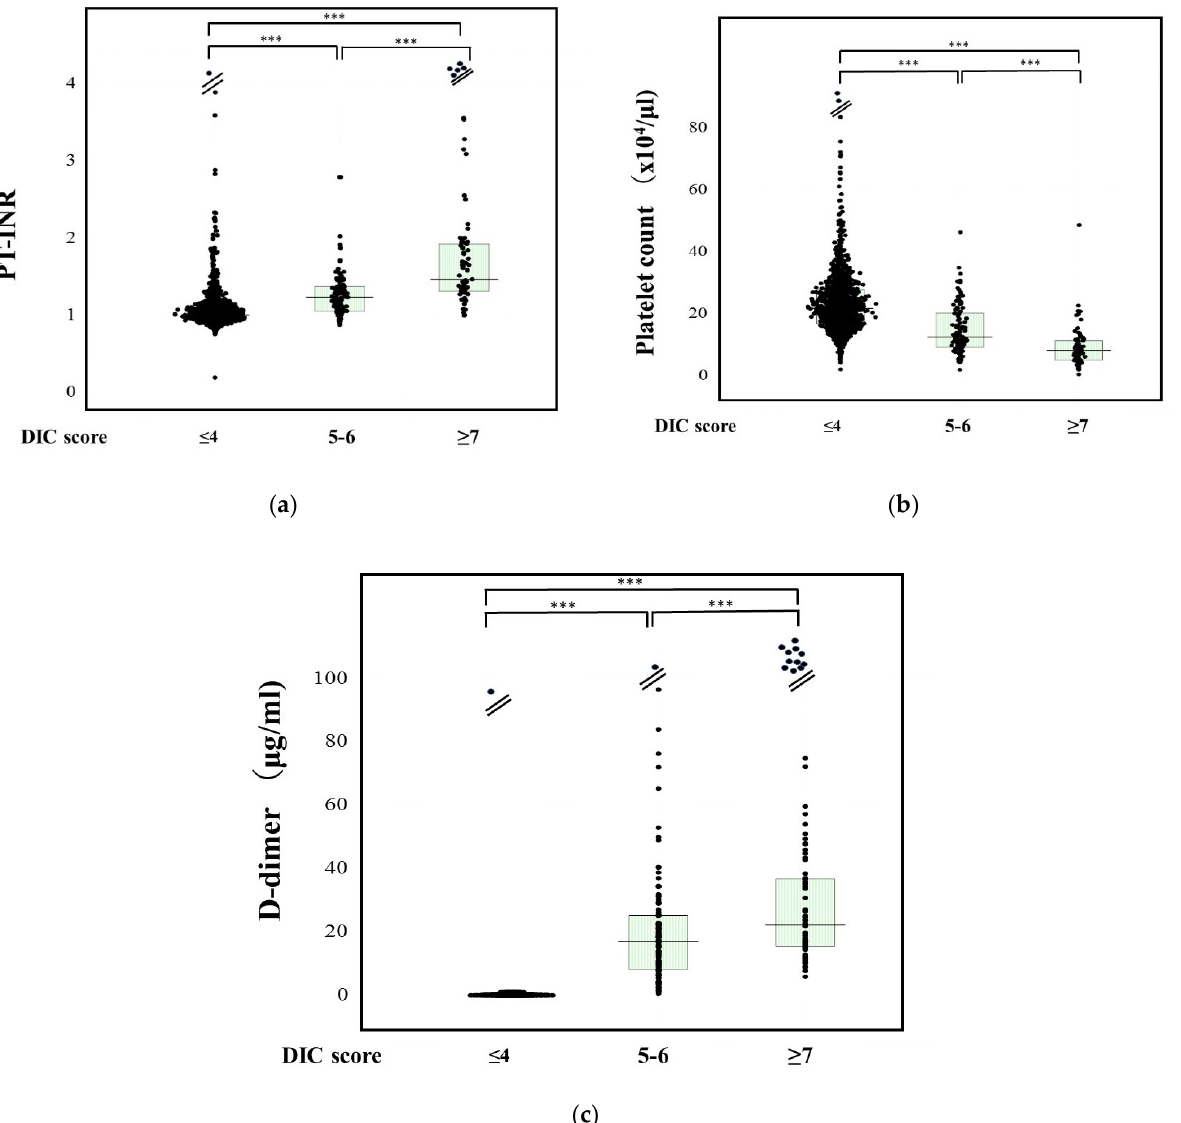
Figure 1. PT-INR ( a ), platelet counts ( b ), and D-dimer ( c ) DIC, disseminated intravascular coagulation; PT-INR, prothrombin time–international normalized ratio. ***, p < 0.001 The D-dimer levels in patients with DIC (25.0 μ g/mL: 16.1–47.8 μ g/mL) were significantly higher than those in patients with pre-DIC (17.0 μ g/mL: 8.2–25.7 μ g/mL) or non-DIC (1.7 μ g/mL: 0.7–4.8 μ g/mL), and in those with pre-DIC than in those with non-